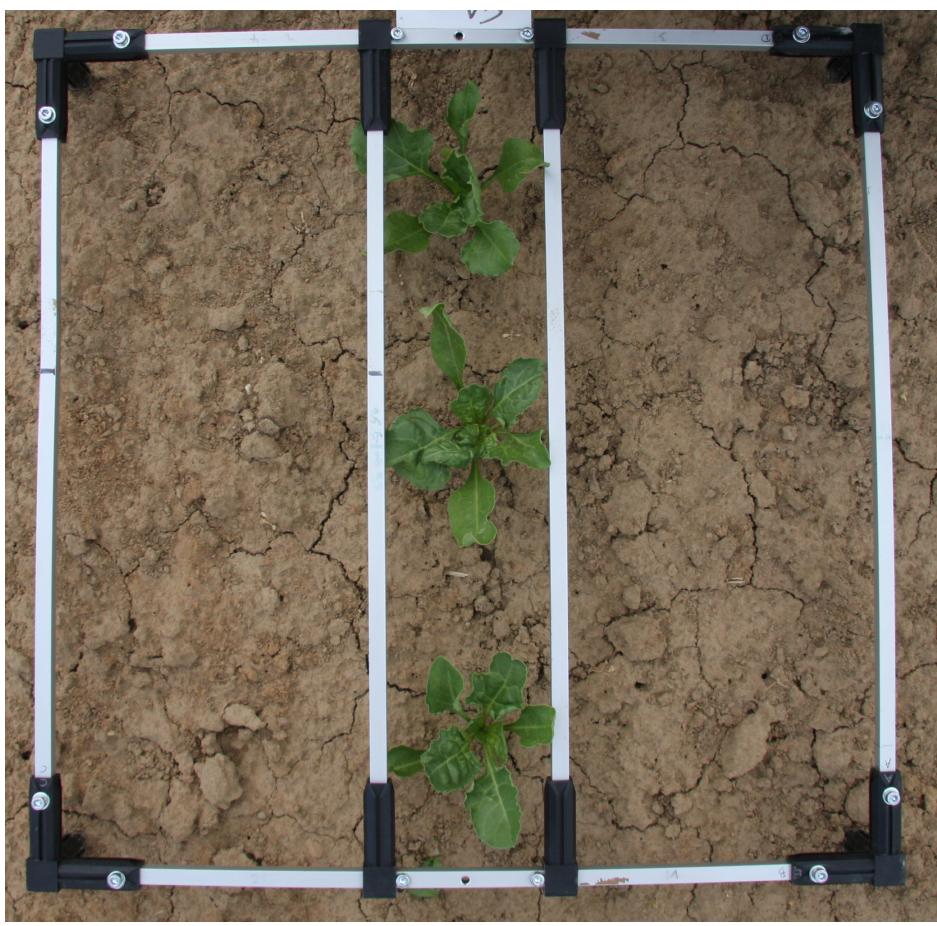
Figure 4. The frame (0.5 × 0.5 m) that was used for the measurements of the weed density in 2017 and